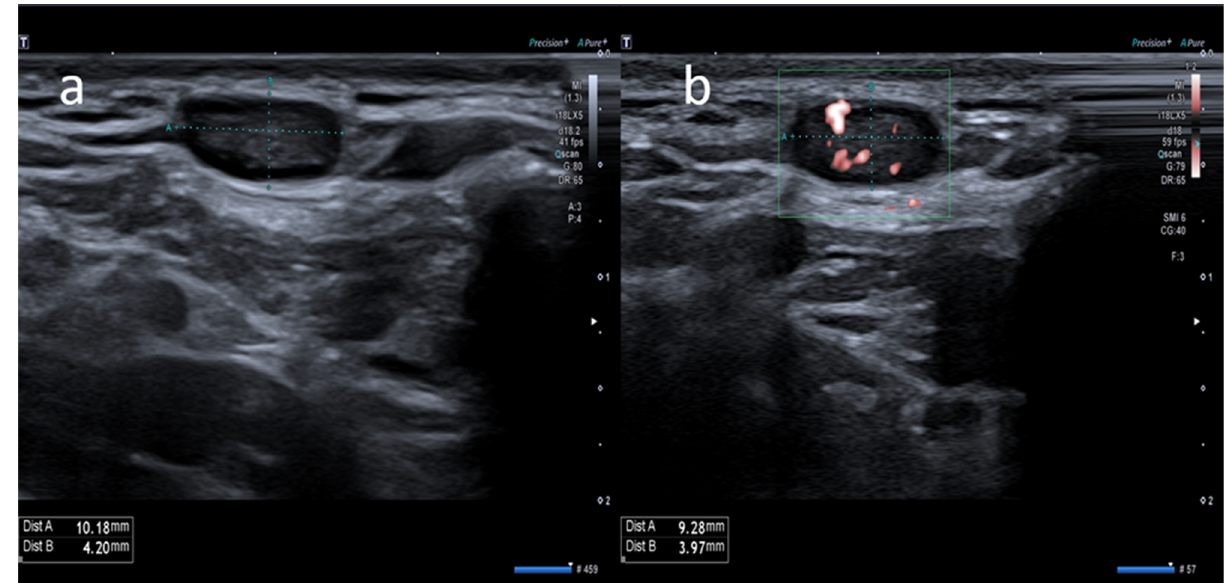
Figure 4. A 35-year-old male with palpable unilateral nuchal adenopathy noted three days after receiving the second dose of the Moderna COVID-19 vaccine in his left deltoid muscle. ( a ) B-mode sonogram image shows a lymph node ovalar hypoechoic with hilum absence. ( b ) SMI image shows central and peripheral vascularization.